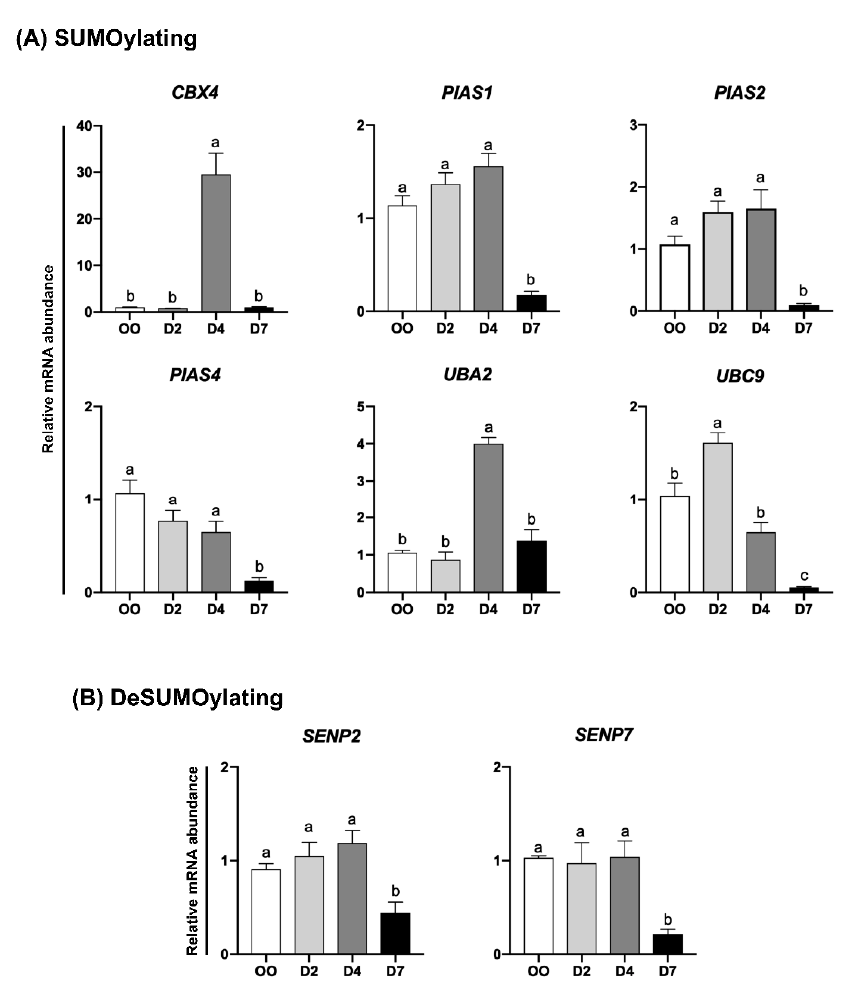
Figure 3. Relative mRNA abundance of genes encoding SUMOylation ( A ) and deSUMOylation ( B ) enzymes in porcine oocytes and embryos at different stages of development. OO, MII oocytes; D2, day 2 embryos; D4, day 4 embryos; D7, day 7 blastocysts. Different letters indicate statistical differences ( p < 0.05) between developmental stages.